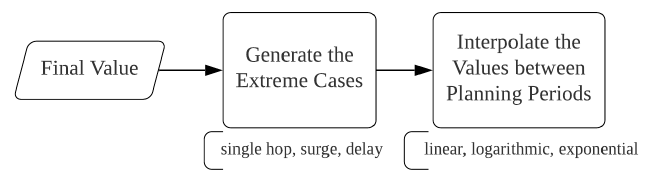
Figure 7. Manual Generation to handle the extreme cases. Figure 8 outlines the random sampling for the middle cases. The solution space